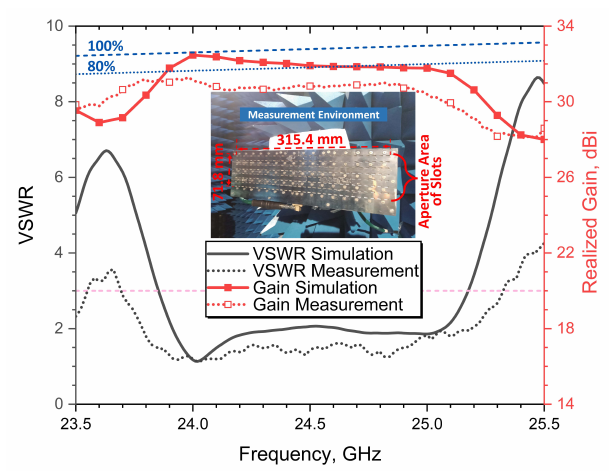
FIGURE 4. Numerical results of radiation and total efficiency as a function of frequency.